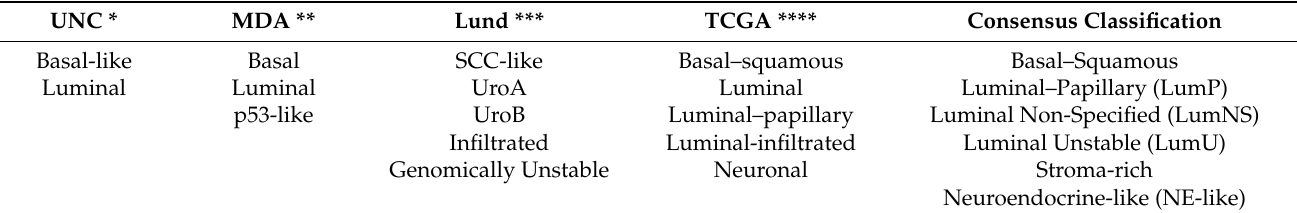
Table 1. Summary of the main molecular classification systems in BC